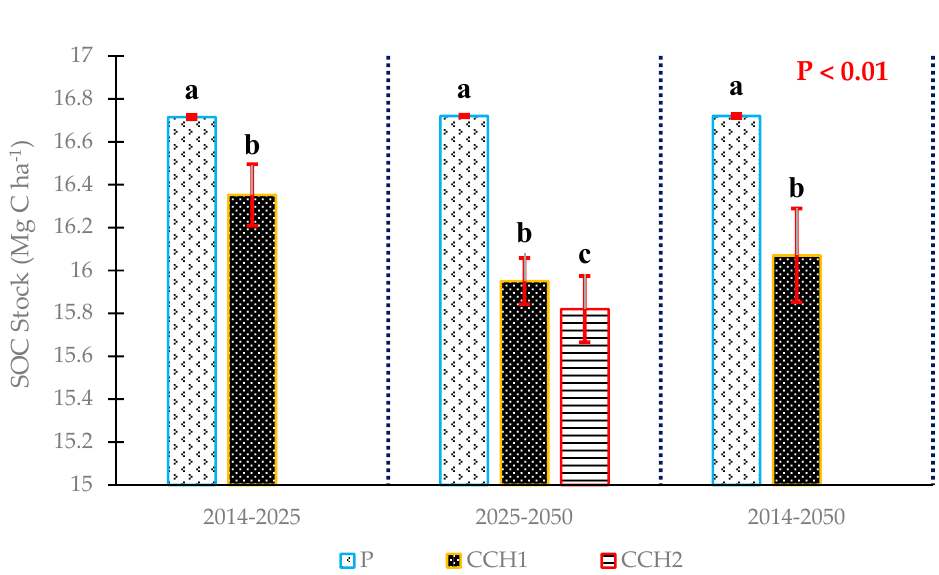
Figure 4. Simulated yearly SOC dynamics under three climate scenarios (P, CCH1 and CCH2).